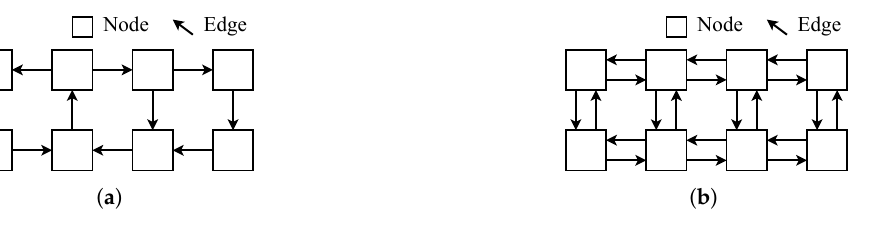
Figure 1. Modeling of AGV transportation systems. AGVs are placed at one of the nodes and can move to adjacent nodes per step. It is not possible for multiple AGVs to be present at the same node at the same time or for two AGVs to move interchangeably between adjacent nodes. ( a ) Unidirectional transport system. AGVs at a node can only move to the node in the direction of the edge. ( b ) Bidirectional transport system. AGVs can move to all adjacent nodes if the edges are